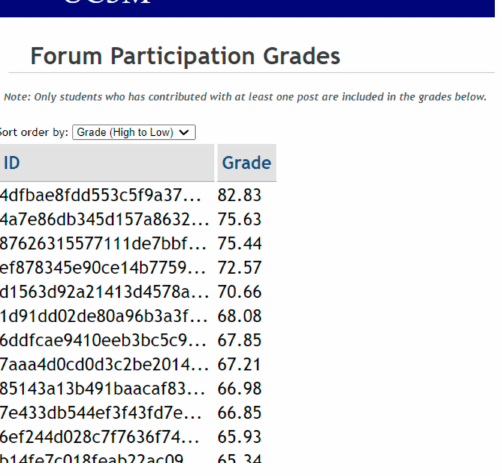
Figure 9. Example with Forum Participation Grades (maximum possible grade